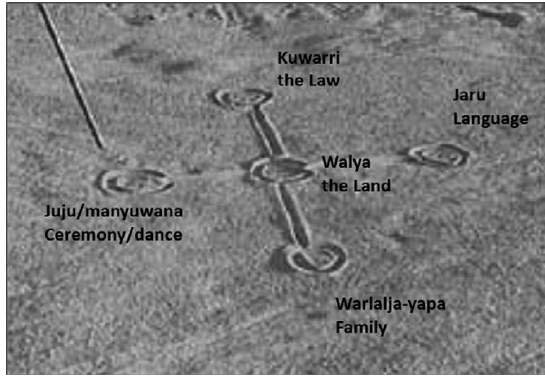
Ways of working with Warlpiri people (adapted from Patrick et al., 2008, pp.